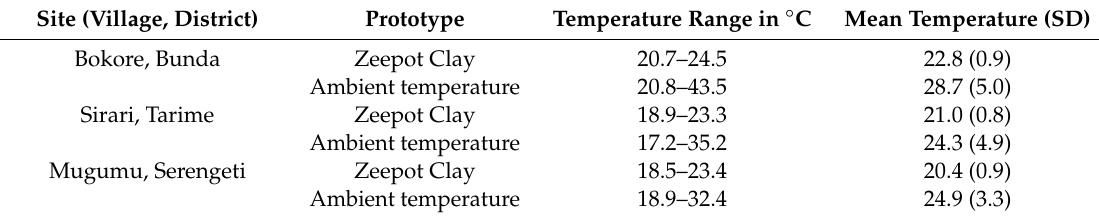
Table 3. The mean ambient temperature and internal temperature of the Zeepot Clay across three sites in the Mara